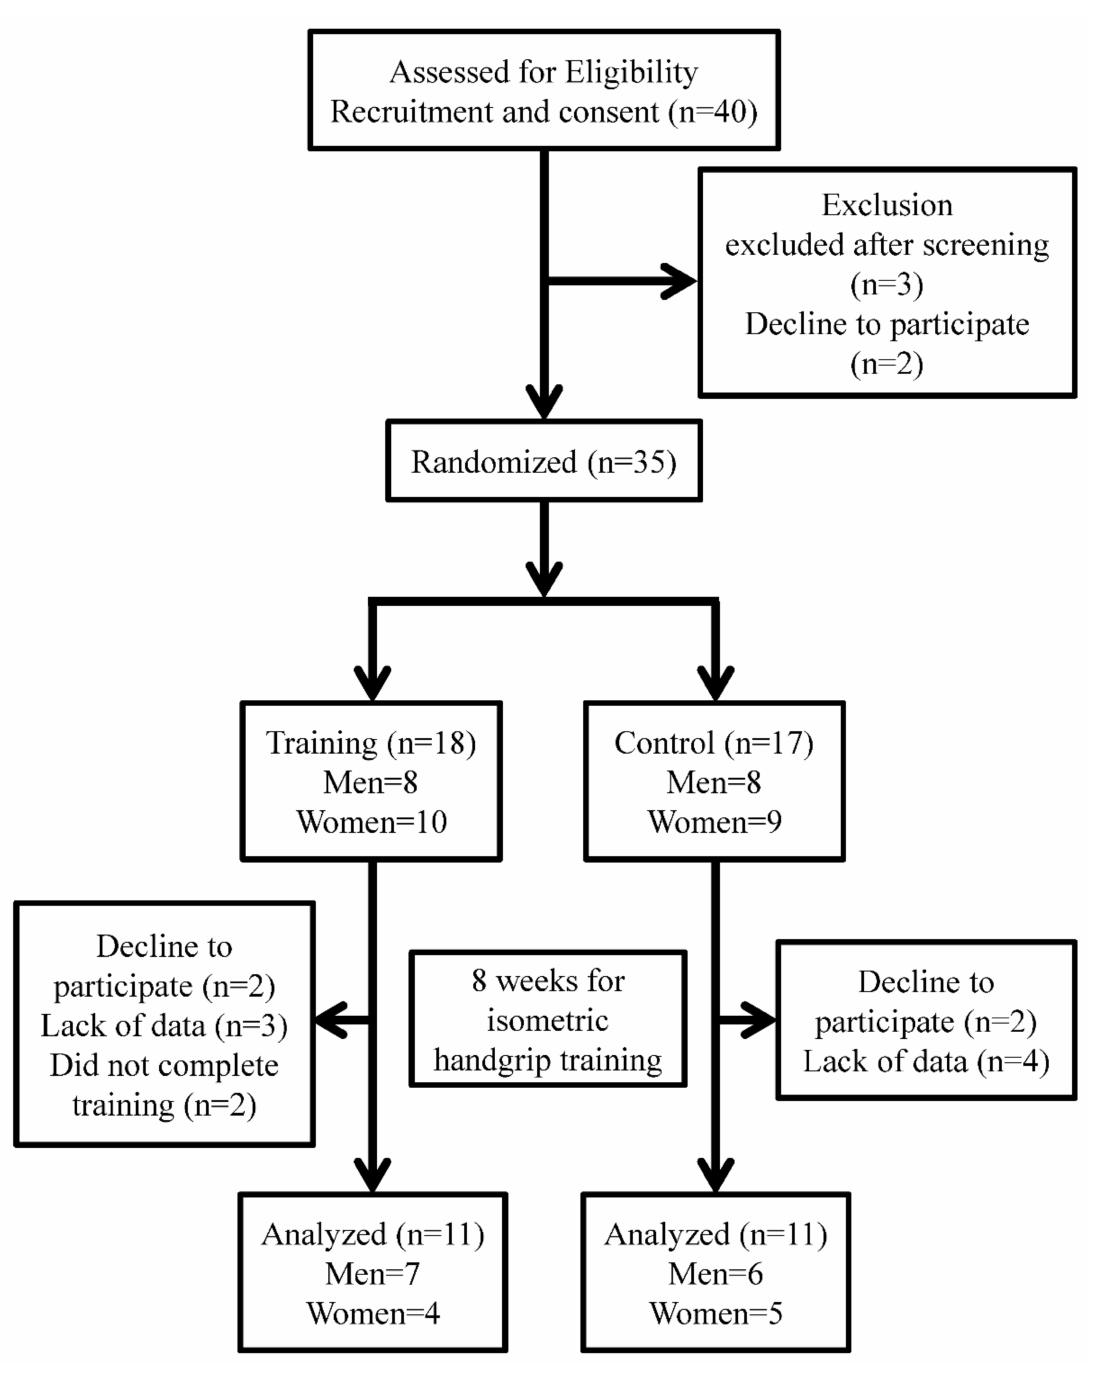
Figure 1. CONSORT flow diagram of the study